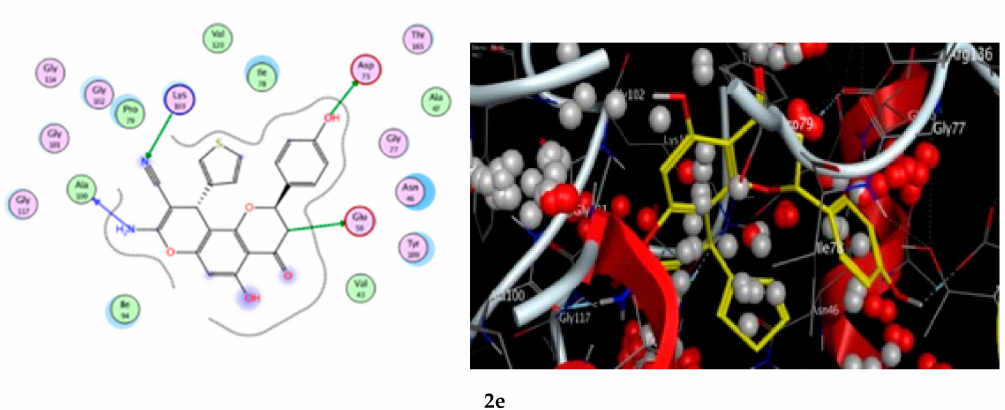
Figure 9. The 2D and 3D binding interaction of the target compounds; ( 2a , 2b , 2d , and 2e ) inside the DNA gyrase enzyme subunit B. ( 2a , 2b , 2d , 2e ). (The compound structures in this figure are 3D molecular structures where blue color is associated with nitrogen, yellow with carbon, red with oxygen, white with hydrogen and green with halogen atoms).